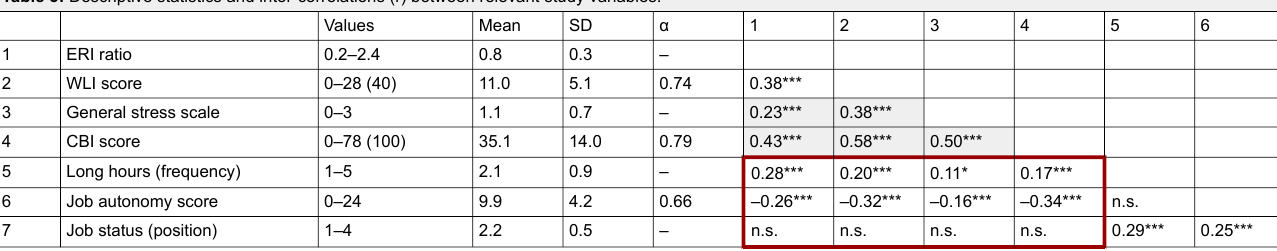
Table 3: Descriptive statistics and inter-correlations (r) between relevant study variables.